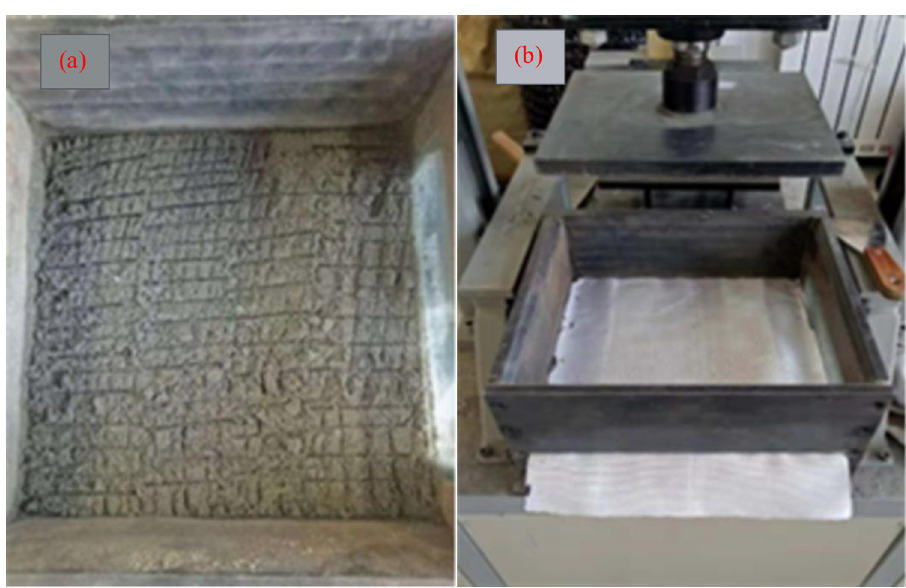
Fig 2. Pull-out test process: (a) Scraping treatment of the contact surface between geotextiles and tailing; (b) Geotextiles are spread through narrow slits and in the test chamber.